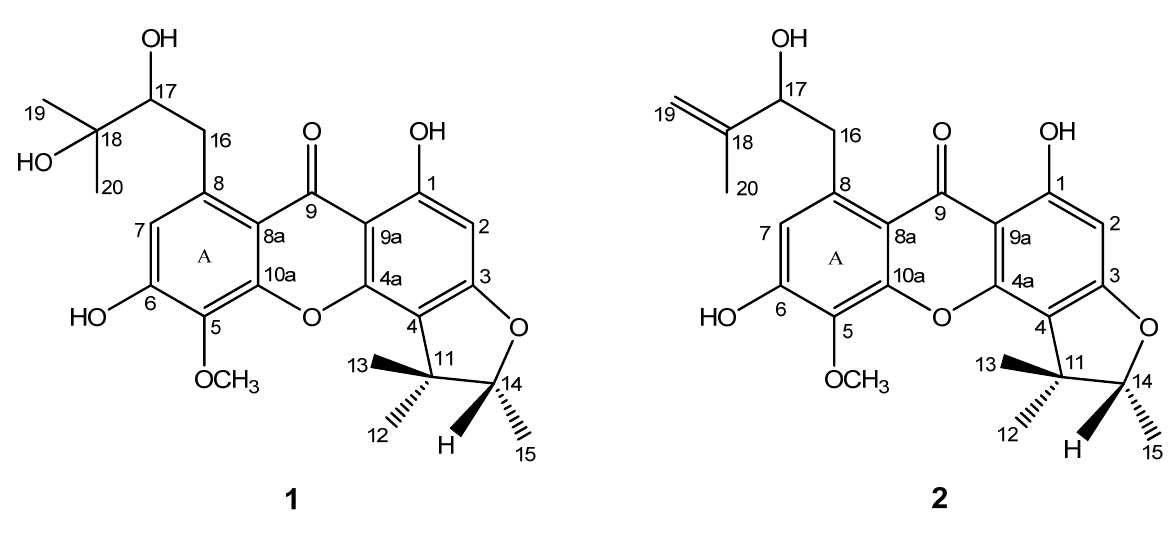
Figure 1. Structures of compounds 1 and 2 .